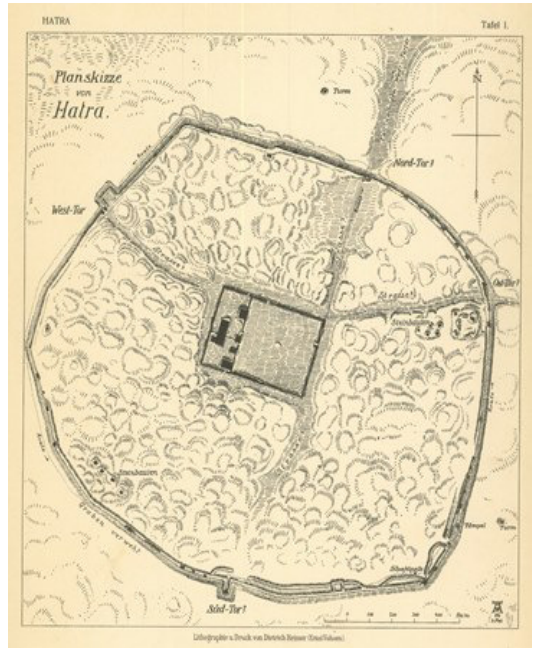
Figure 6. Father A. Poidebard’s aerial photograph of the valley of tower tombs in Palmyra in Syria (Poidebard 1934).